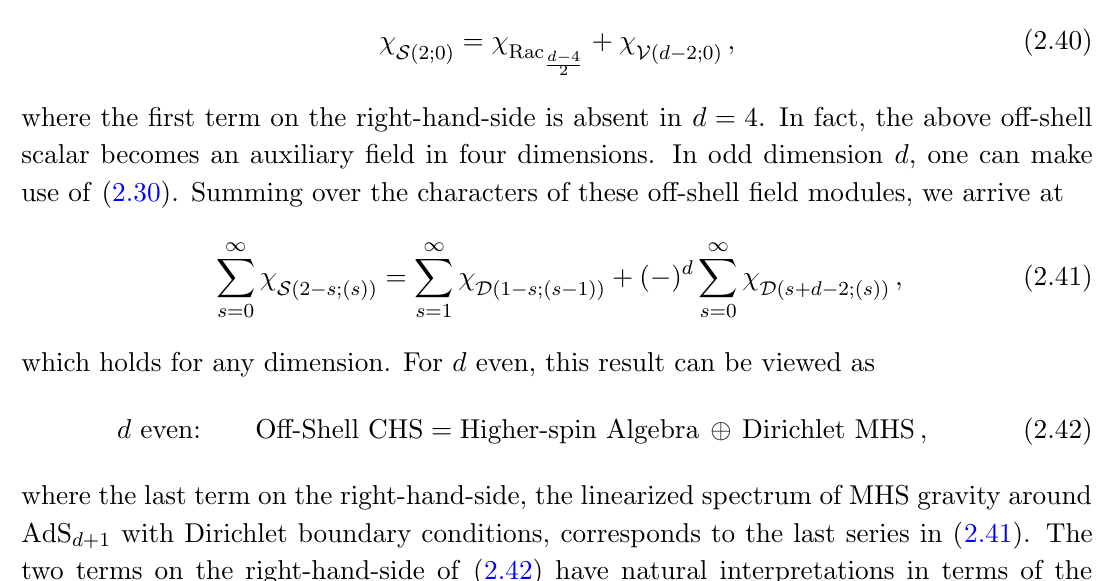
Table 1 . List of relevant (cid:12)elds in Dirichlet vs Neumann MHS theories whereas the o(cid:11)-shell FT scalar S (2; 0) = V (2; 0) is related to the on-shell one